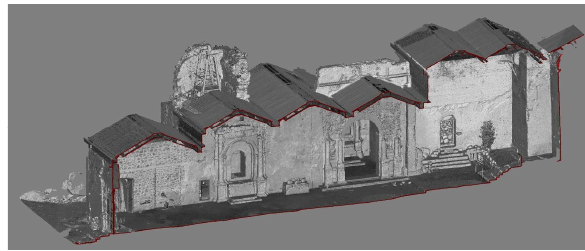
Figure 7. 3D view of the plan section of the point cloud (greyscale reflectance)